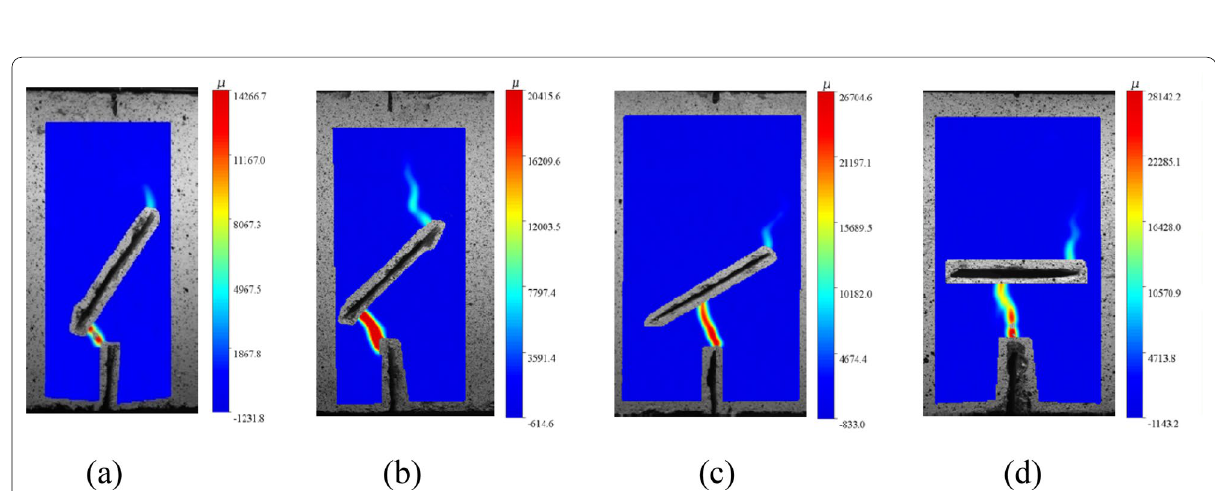
Fig. 13 The representative principal strain fields of the specimens with ( a ) θ 10 –3